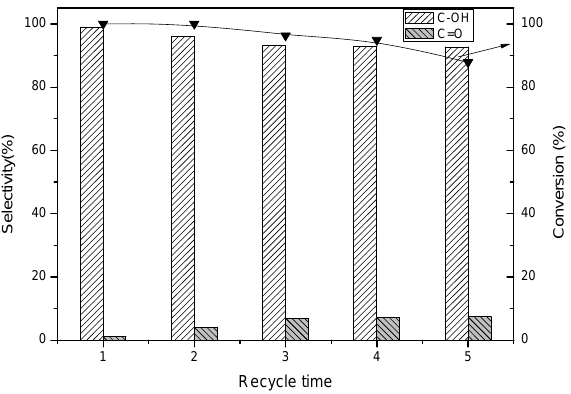
Figure 6. Recycle of the catalyst. Reaction conditions: reactant (0.82 mmol), H 2 O (25 mL), 3 wt. % Pd/ γ -Al 2 O 3 (0.200 g/0.056 mmol Pd), 60 °C, 2 MPa H 2 . 3. Experimental Section